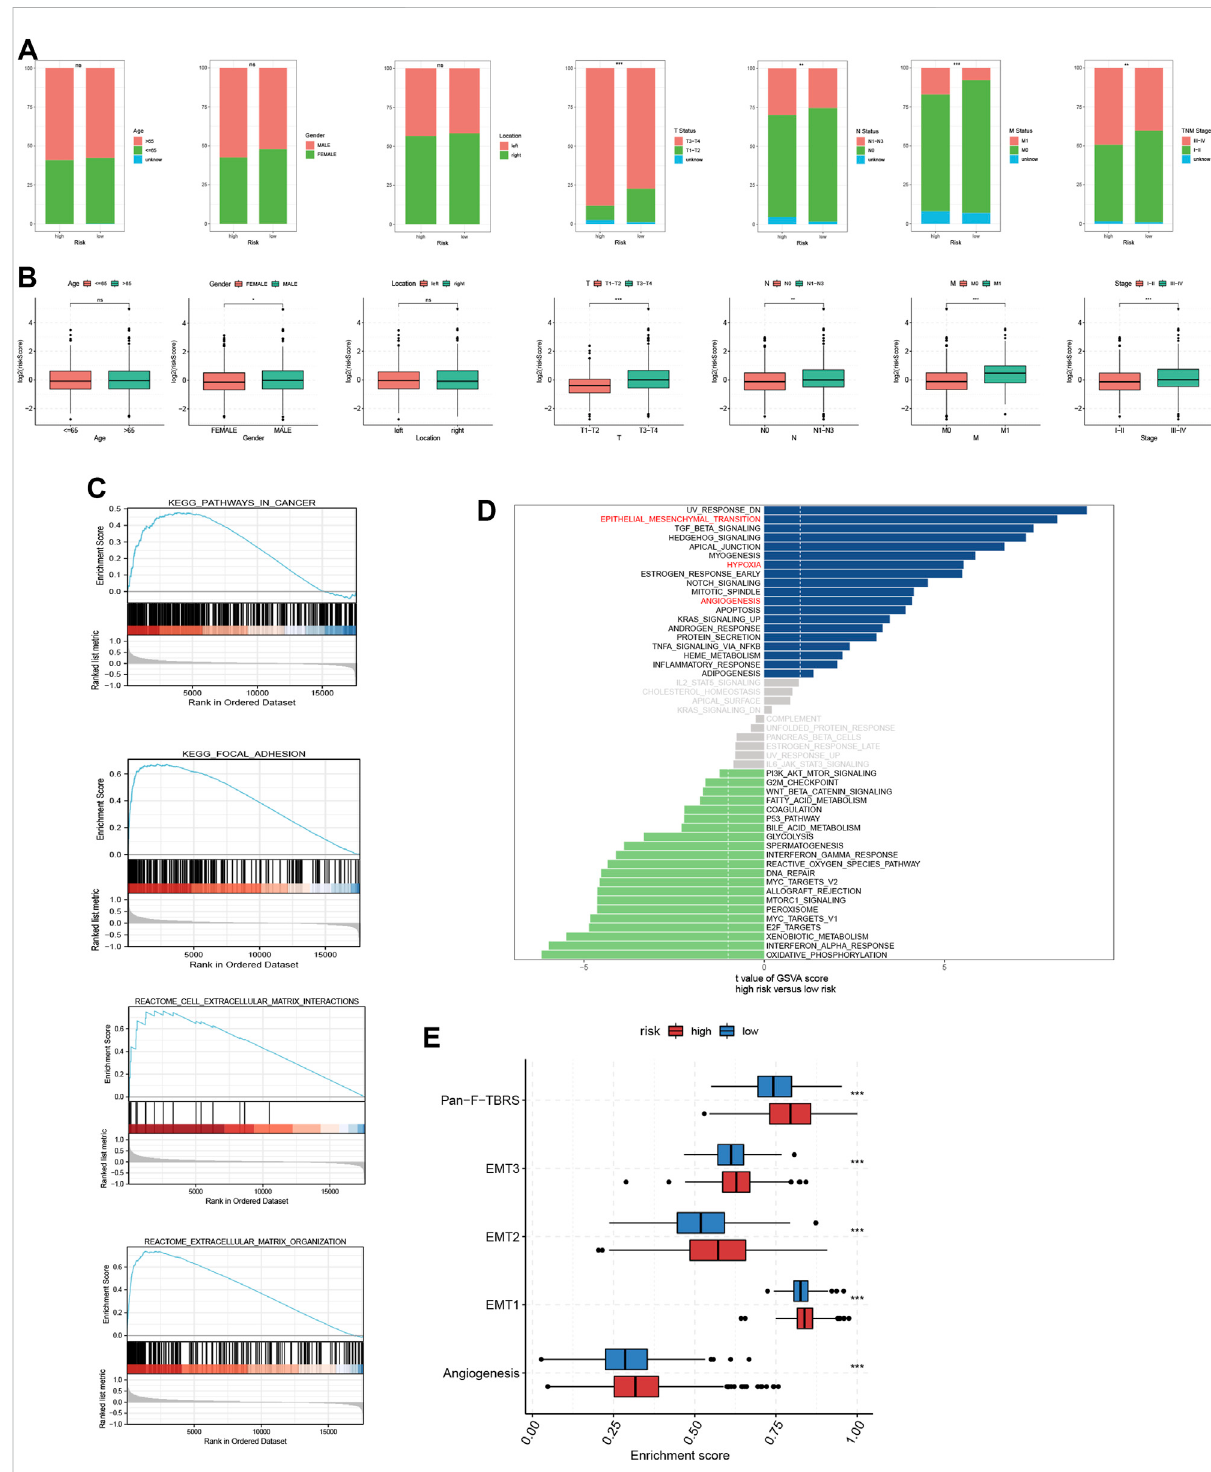
FIGURE 4 Analysis of clinical correlation and biological function for TRMRG risk score signature. (A) Bar plots showing the frequencies of different clinical features including age ( > 65 vs. ≤ 65), gender (male vs. female), tumor location (left vs. right), T status (T1-T2 vs. T3-T4), N status (N0 vs. N1-N3), M status(M0vs.M1)andtumorstage(I-IIvs.III-IV)inhighandlowriskpatients. (B) Boxplotscomparingriskscoredifferencesbetweenmultipleclinical subgroups. (C) GSEAanalysisofTRMRGriskscoresignature. (D) BarplotshowingtheenrichmentpatternofHallmarkitemsforhighandlowrisk patients. (E) Box plots comparing enrichment differences of gene sets developed by Mariathasan et al. Statistical Signi fi cance: * p < 0.05; ** p < 0.01; *** p < 0.001; ns, not signi fi